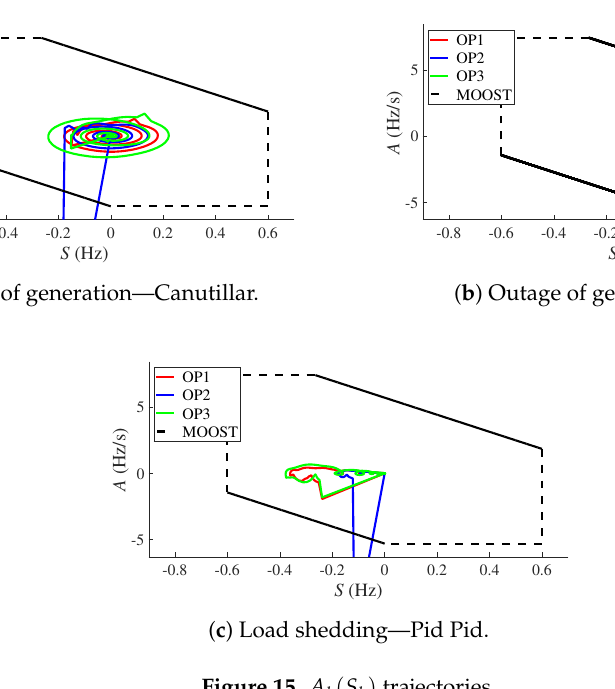
Figure 14. Simplified diagram of Chiloé Island and its surroundings.